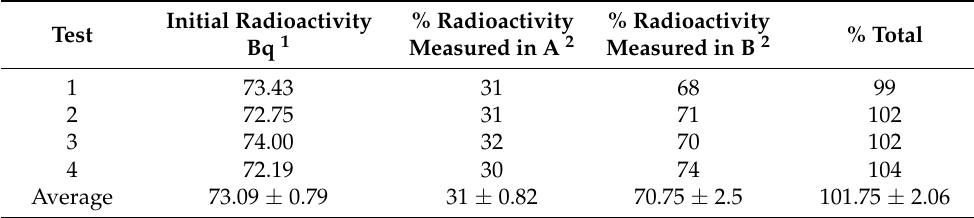
Table 1. Results obtained by applying the 90 Sr (II) and 90 Y(III) uptake methodology using Phy@Fe 3 O 4 nanoparticles.